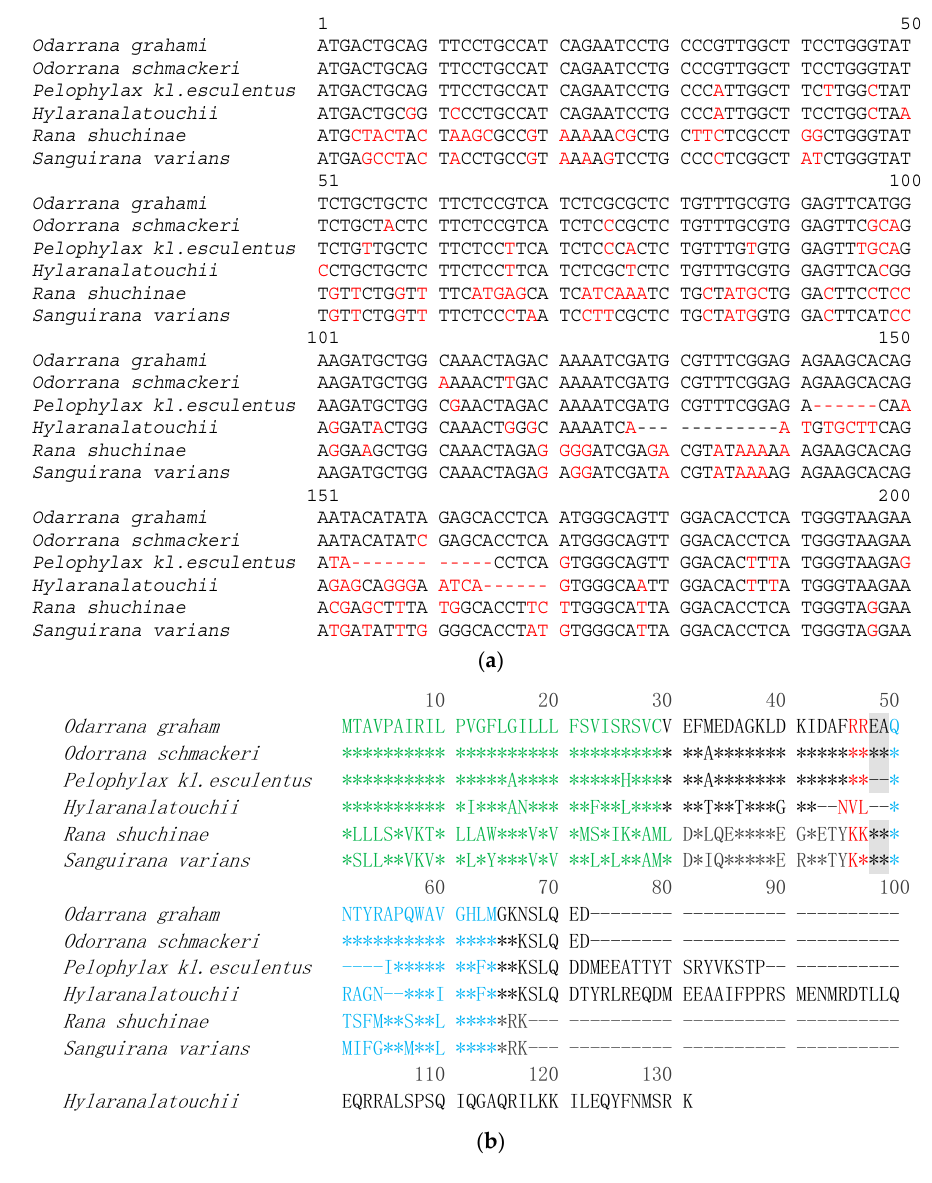
Figure 2. Alignments of partial nucleotides and translated open-reading frame amino acids sequences of bombesin peptides from different species of the Ranidae family. ( a ) Partial nucleotides sequences of bombesin peptides from different species of the Ranidae family; ( b ) The translated open-reading frame amino acids sequences of bombesin peptides from different species of the Ranidae family. The different nucleotides in ( a ) are labelled in red. The sequences of mature peptides in ( b ) are labelled in blue. The sequence of signal peptide are labelled in green. Stars (*) indicate the identical amino acid residues. The processing sites of the precursor for releasing mature peptides are labelled by red. The second possible processing sites are in shadow. Gaps (dashed line) were introduced to optimise the identities.